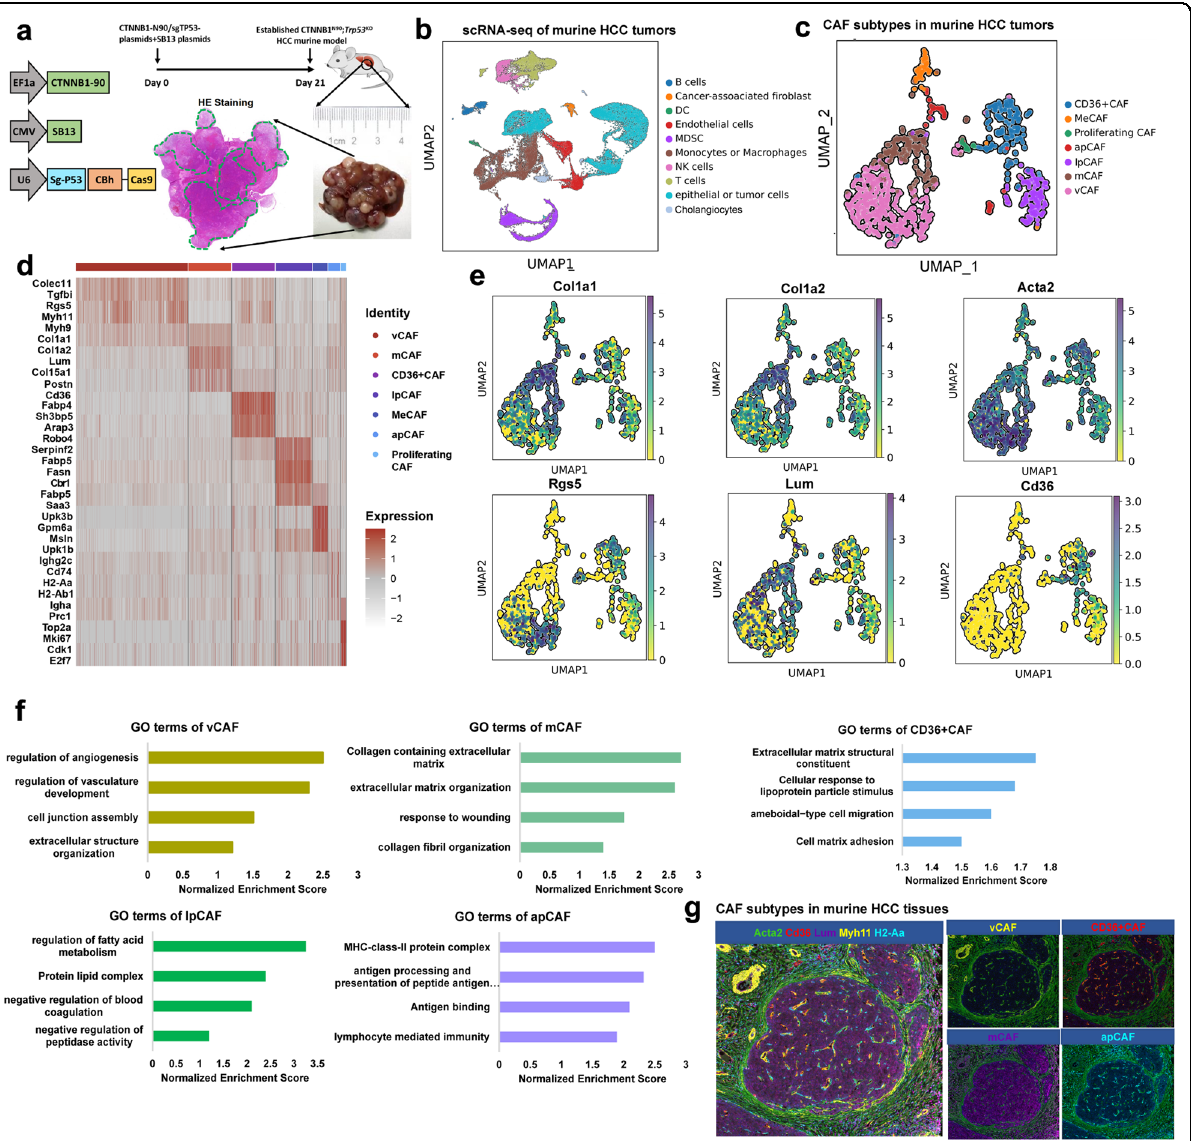
showing different cell types from scRNA-seq data in murine HCC tissues. c UMAP plots showing CAF subtypes in murine HCC tissues. d Heatmap showing the top DEGs (Wilcoxon test) in each cell types in murine HCC tumors. e UMAP plots for each marker genes in murine CAF subtypes. f GO analysis in different murine CAF subtypes. g Multiplex immuno fl uorescence staining showed major CAF clusters existed in murine HCC